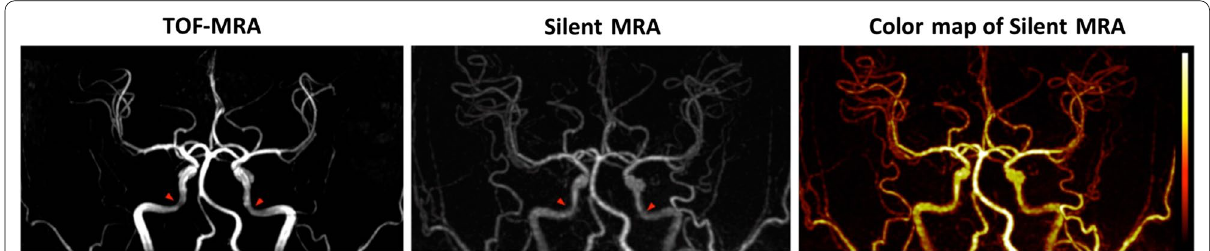
Fig. 2 Arterial structures acquired using Silent MRA and 3D TOF‑MRA. Red arrows indicate the petrous segments of internal carotid arteries. Silent MRA shows comparatively less signal loss. Using the arterial spin‑labeling technique, Silent MRA provides flow information in the gradient magnitudes of the arterial